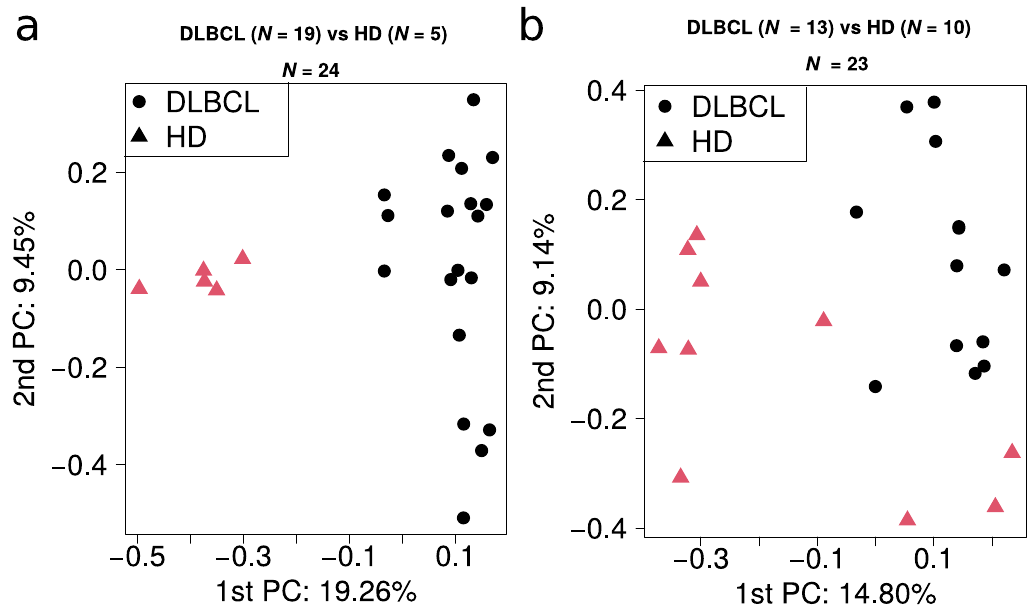
Figure A5. Principal component analysis of all quantitative values obtained from ( a ) batch 1 and ( b ) batch 2.